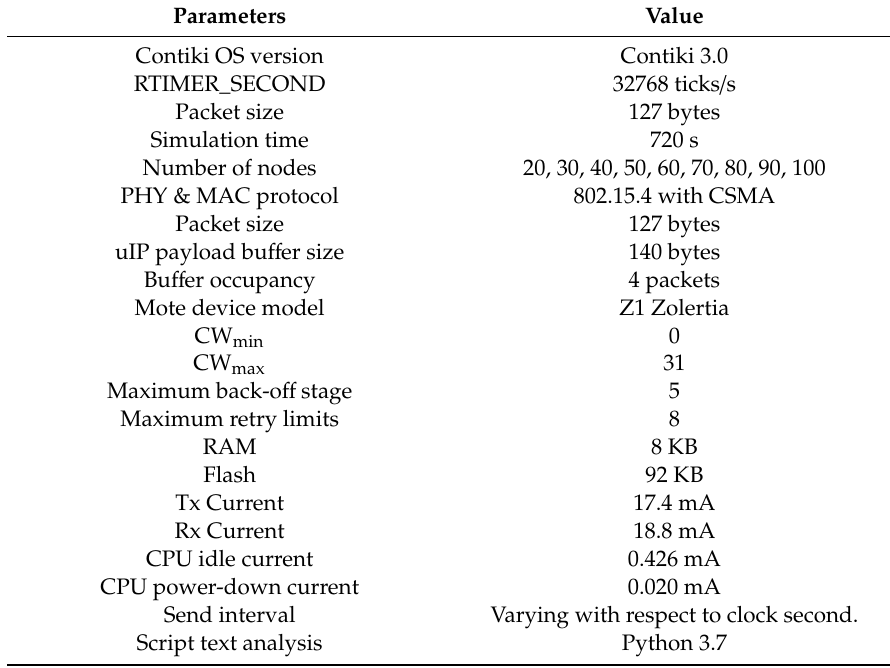
Table 1. Simulation